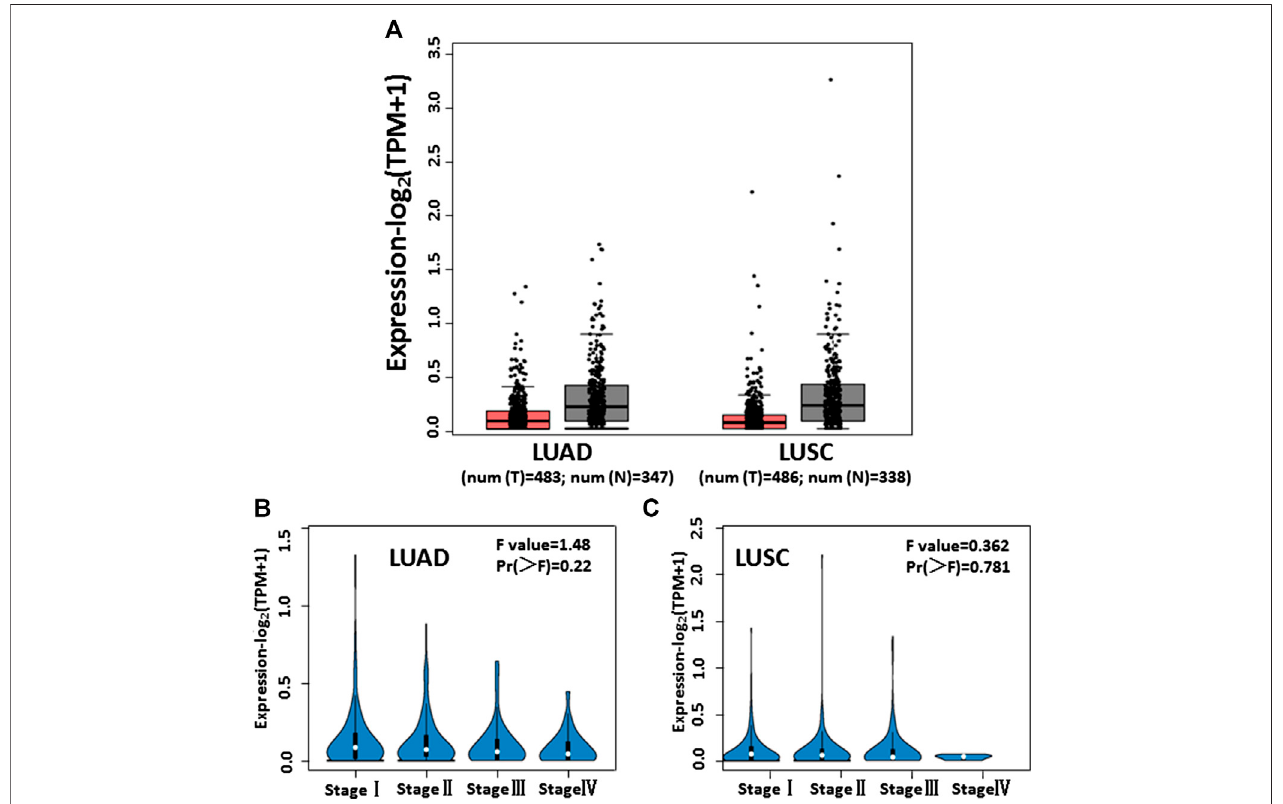
FIGURE 6 | The levels of IL-13 expression in NSCLC cells analyzed according to cancer public database. (A) IL-13 expression pro fi le across tumor samples and adjacent normal tissues from GEPIA in LUAD and LUSC. (B , C) IL-13 expression levels in different stages of LUAD and LUSC from GEPIA database.